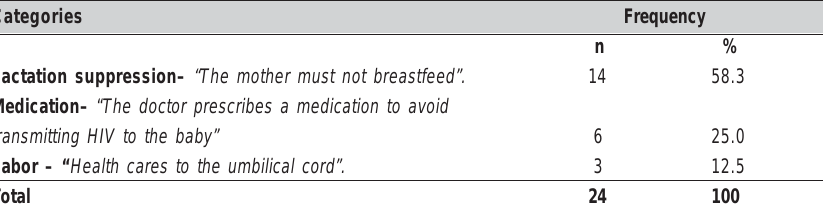
Table 2 – Percentage and absolute frequency distribution of the categories referring to the positive answers about the awareness of prevention of MTCT of HIV.